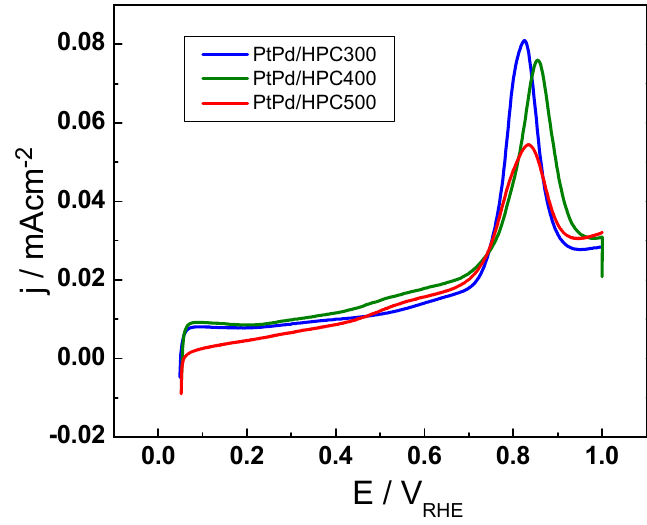
3. CO stripping voltammograms for PtPd/HPC300, PtPd/HPC400